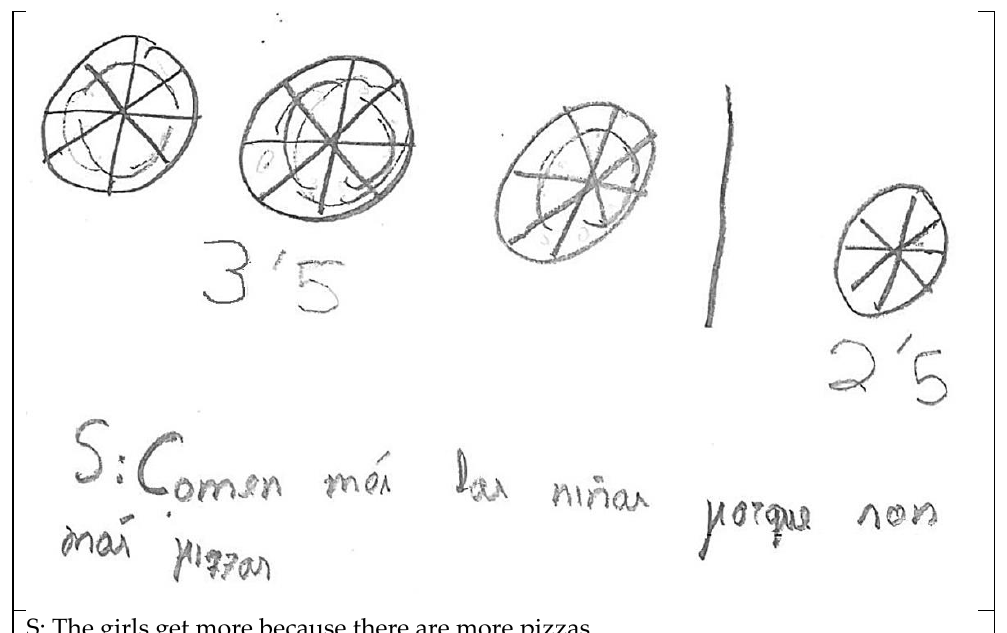
Figure 2. Example of application of the pre-within combined with the pieces strategy.